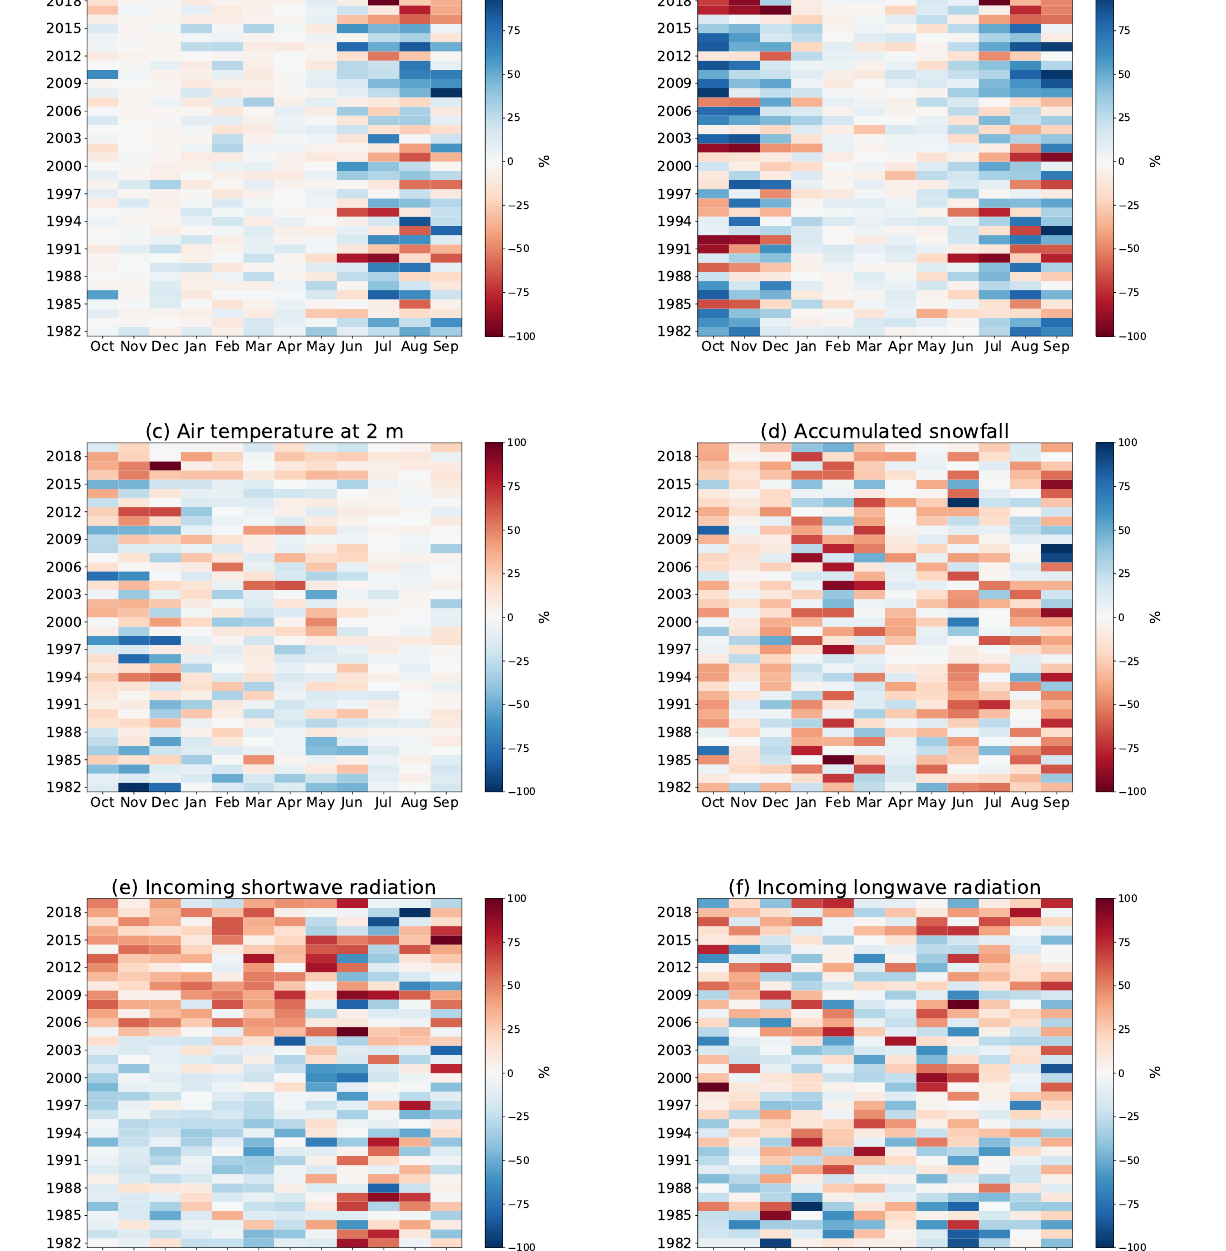
Figure 7. Monthly mean deviations 1982 to 2019 from long-term monthly mean values in percent (±100% is maximum and minimum deviation) of glacier-wide climatic mass balance ( a ), albedo ( b ), air temperature at 2m ( c ), accumulated snowfall ( d ), incoming shortwave radiation ( e ) and incoming longwave radiation ( f ). The color bar is arranged so that deviations that act positively (negatively) on glacier-wide climatic mass balance are shown in blue